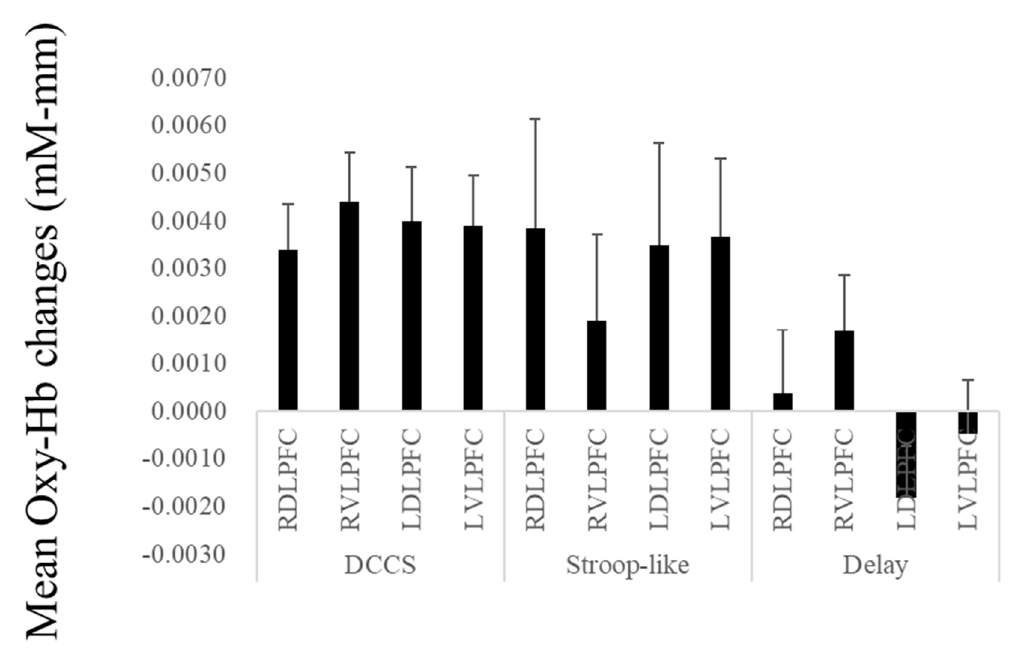
Figure 1. The mean changes in oxy-Hb during the DCCS, Stroop-like, and delay-of-gratification tasks. Error bars indicate standard error. Footnote: RDLPFC, right dorsolateral prefrontal cortex; RVLPFC, right ventrolateral prefrontal cortex; LDLPFC, left dorsolateral prefrontal cortex; LVLPFC, left ventrolateral prefrontal cortex.